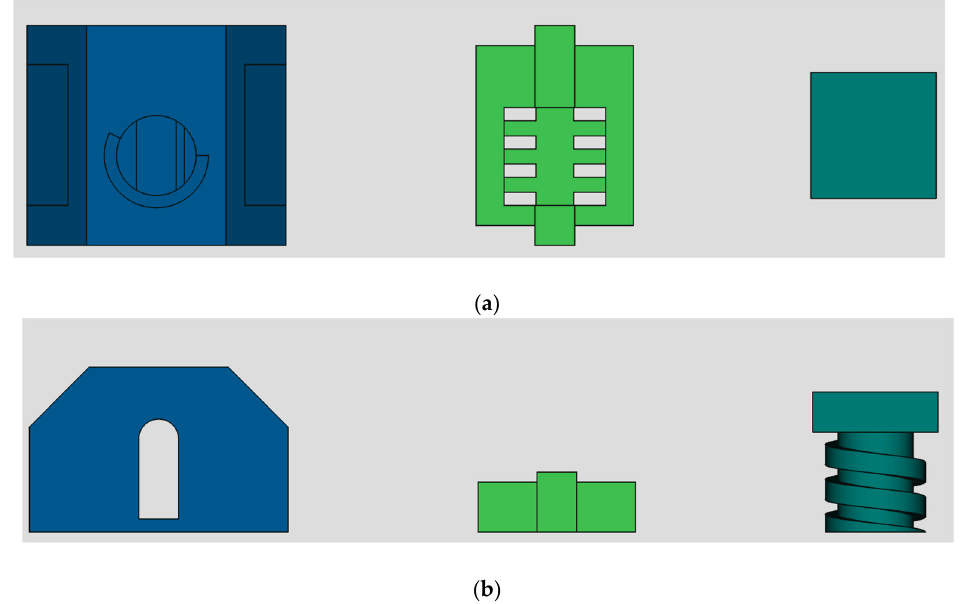
Figure 1. FreeCAD view of the enclosure ( left ), component housing ( center ), and securing bolt ( right ); ( a ) top view; ( b ) rear view.